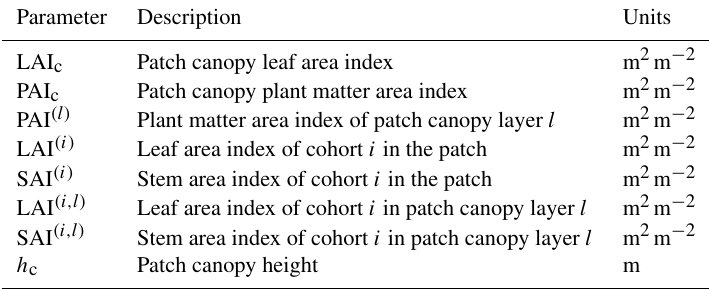
Table B1. Ecosystem structure.